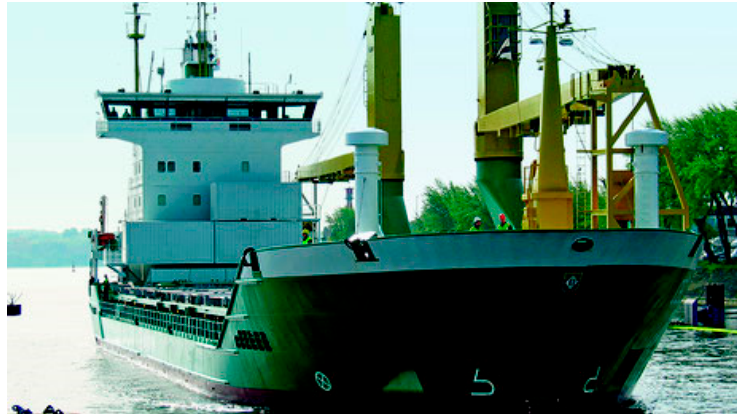
Figure 10. The ship “MS Forester” [66].